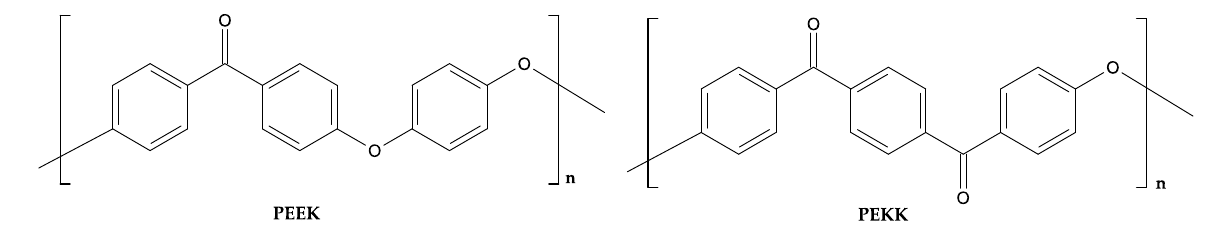
Figure 6. PEEK and PEKK chemical formulas.